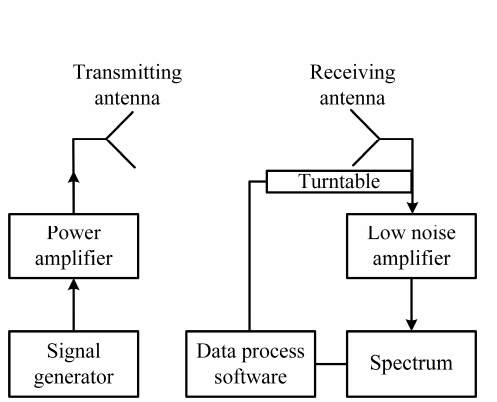
Figure 7. Simplified diagram of the measurement framework.